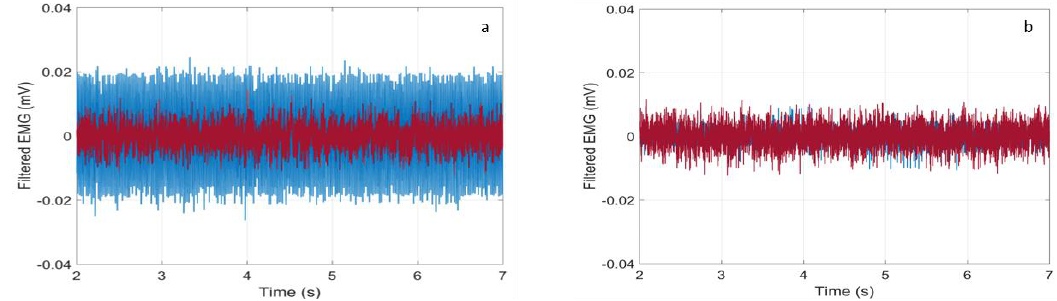
Figure 9. Zoom of the baselines of the wearable device (red line) and the conventional wired equipment (blue line) ( a ) without Notch filter and ( b ) with the Notch filter. The traces refer to a rest time interval in a test on the abductor pollicis brevis.